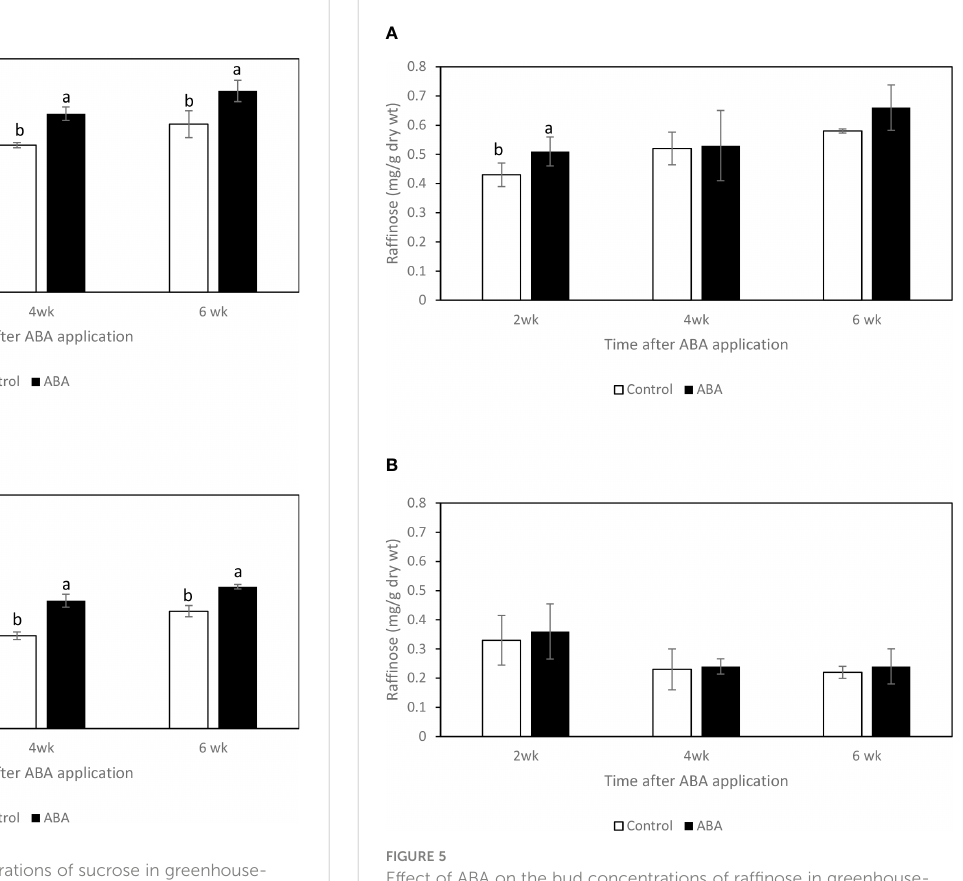
FIGURE 4 Effect of ABA on the bud concentrations of sucrose in greenhouse- grown grapevines (A) ‘ Chambourcin ’ and (B) ‘ Cabernet franc ’ . Bars with different letters are signi fi cantly different at p ≤ 0.05. (n = 4). Standard errors are presented.